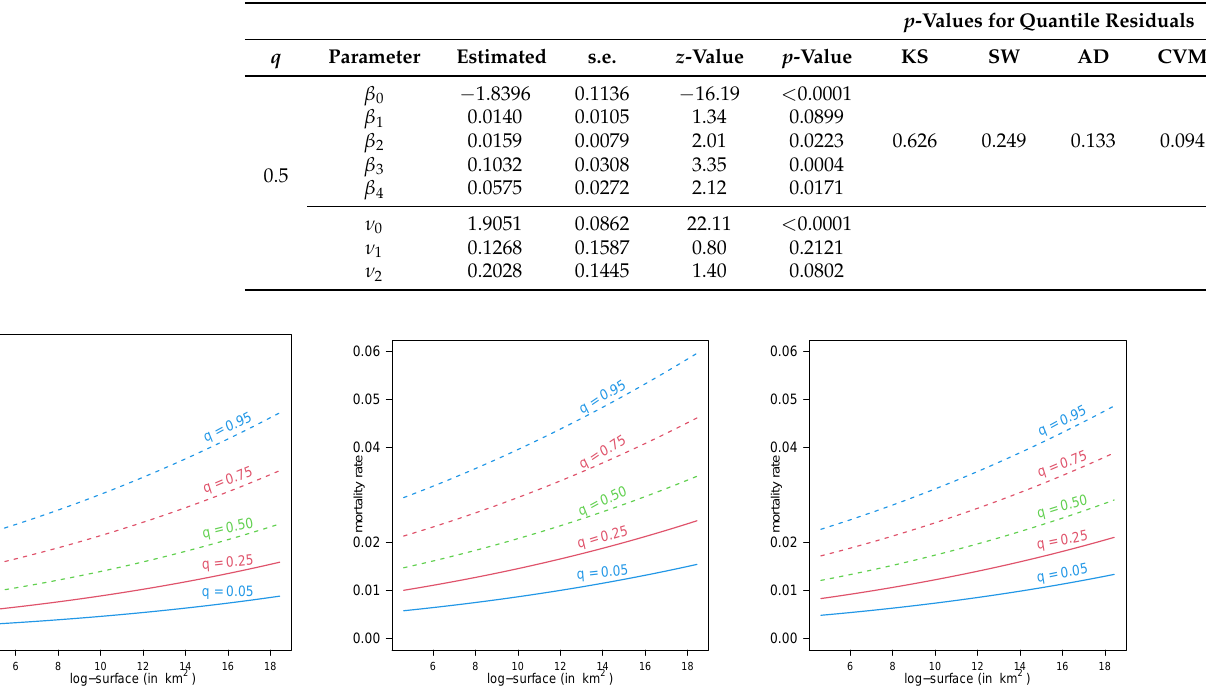
Table 5. The estimated parameters and standard errors (s.e.) for different quantiles in the RPGJSB2 q = 0.5 model of the COVID-19 data set with G the cdf of the normal model and loglog link. The p -values for the traditional normality test for the RQRs are also presented. p -Values for Quantile Residuals q Parameter Estimated s.e. z -Value p -Value KS SW AD CVM